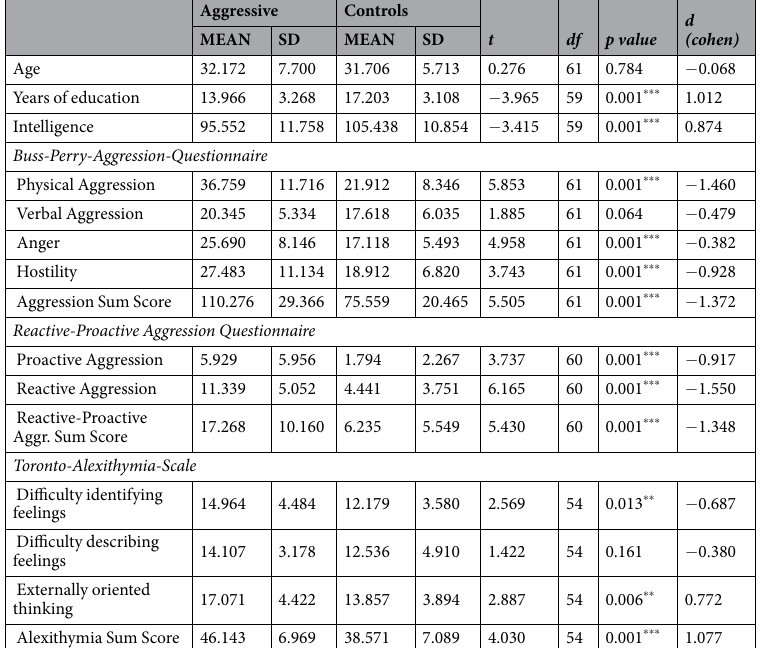
Aggressive Controls